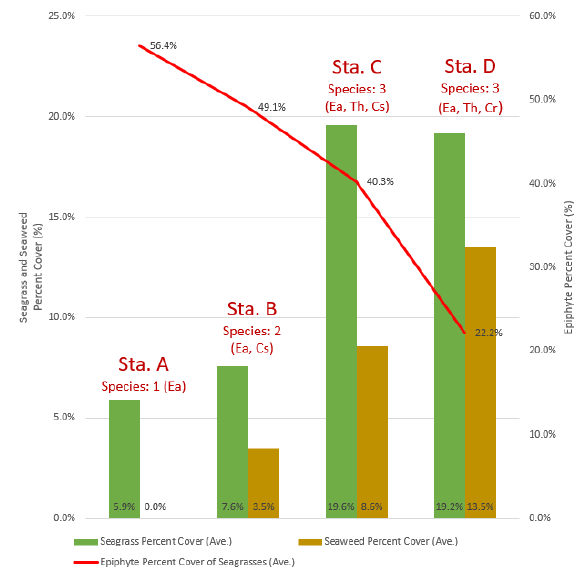
Figure 8. Summary of SAV field survey showing averages of